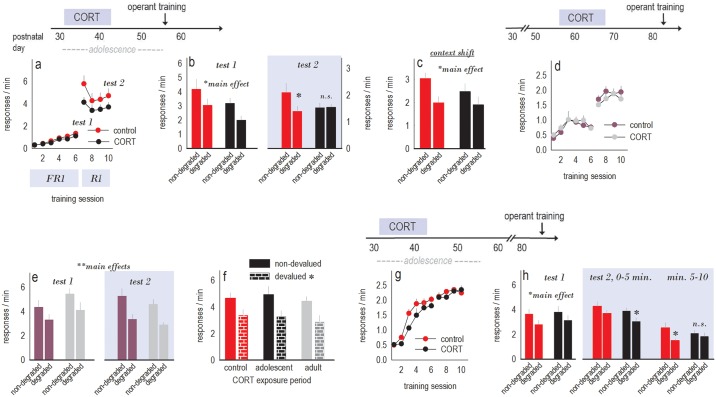
Greater vulnerability to CORT-induced habits in adolescents than adults.Experimental timelines are positioned above the response acquisition curves associated with each experiment. Response acquisition curves represent both responses/min, and breaks in the curves represent tests for sensitivity to instrumental contingency degradation. (a) Instrumental response acquisition was intact 2 wk following adolescent CORT exposure. Text below the x axis notes the schedules of reinforcement used throughout (FR1 before test 1, followed by an RI schedule). (b) Sensitivity to instrumental contingency degradation was also initially intact (test 1) in that mice inhibited a response that was unlikely to be reinforced (“degraded” condition), but CORT-exposed mice then developed habit-based response strategies, failing to differentiate between responses (test 2). n = 8–9/group. (c) In a separate group, test 2 was conducted in a distinct environment (“context shift”). In this case, all mice preferentially engaged the response most likely to be reinforced in a goal-directed manner, indicating that CORT-induced habits (in b) are context dependent. n = 7/group. (d) A history of subchronic CORT exposure in adulthood also did not impact instrumental response acquisition. (e) Unlike with adolescent CORT exposure, however, both groups inhibited a response that was unlikely to be reinforced in a goal-directed fashion. n = 7/group. (f) Additionally, all mice inhibited responding following prefeeding with the reinforcer pellets (“devalued”), relative to prefeeding with chow (“non-devalued”), regardless of age of CORT exposure. (g) Another group of adolescent CORT-exposed mice was allowed a longer (4-wk) washout period in order to match the timing of testing in adult CORT-exposed mice. Mice acquired the responses without group differences. (h) Response preferences were intact in test 1, as above. During test 2, mice were initially able to differentiate between the responses that were likely versus unlikely to be reinforced, but response preference decayed in the CORT-exposed mice. n = 11–12/group. Bars/symbols = means + SEMs, * p < 0.05, ** p < 0.001 versus nondegraded or main effects, as indicated. Raw data for this figure can be found in S1 Data. CORT, corticosterone; FR1, fixed ratio 1; RI, random interval.